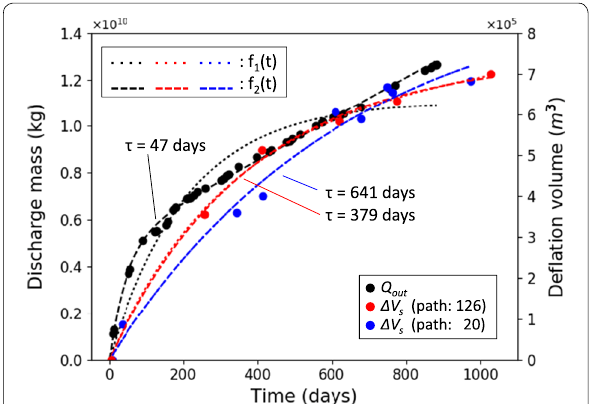
Fig. 4 Time series of the discharge mass ( Q out ) and the deflation volume (Δ V s ). Time plots correspond to the period after 28 September 2014. Plots of Δ V s are based on the estimation for the two independent orbits of ALOS-2 satellite (Narita and Murakami 2018). Dotted lines show best-fit functions of f 1 ( t ) resulted from curve fitting, whereas dashed lines show best-fit functions of f 2 ( t ) (see text for the detail). Note that for Δ V s , f 1 ( t ) and f 2 ( t ) fitting results are almost identical, which means no involvement of linear term. Relaxation time τ in exponential terms is indicated at best-fit time functions of